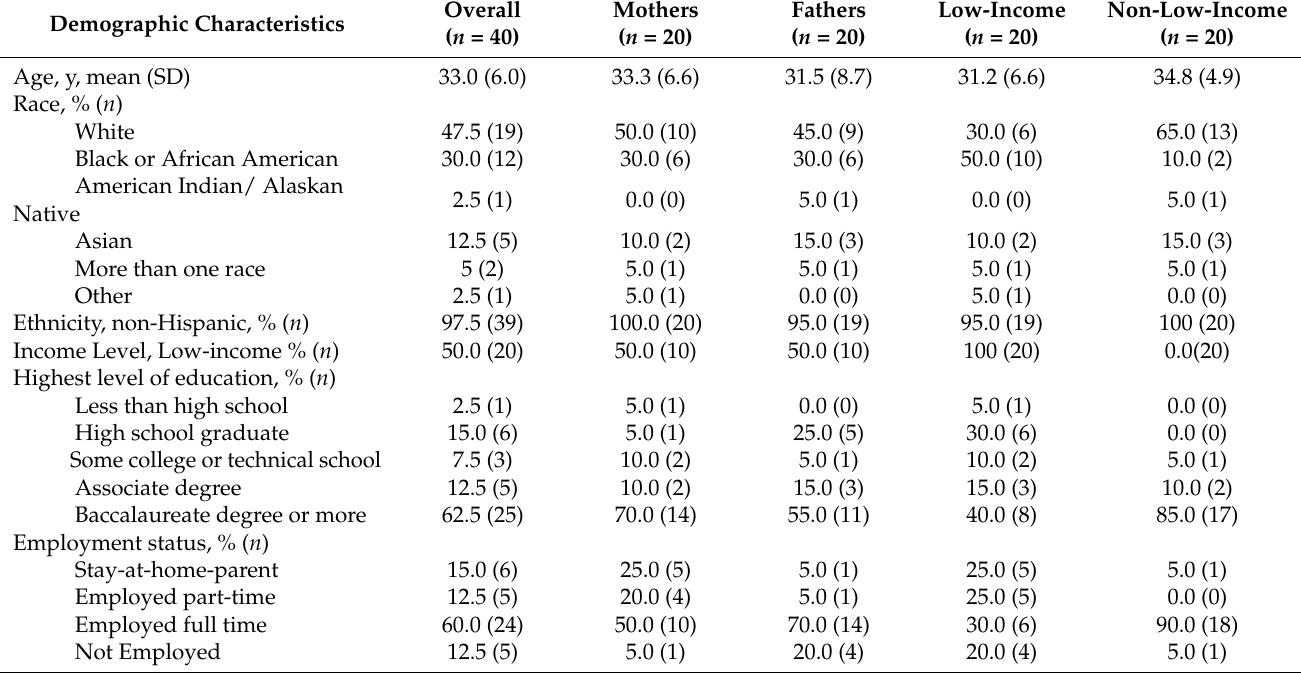
Table 1. Demographic Characteristics and Technology Use of Parents with Children Ages 0–2 Years Participating in an Interview about a Mobile Phone Child Feeding